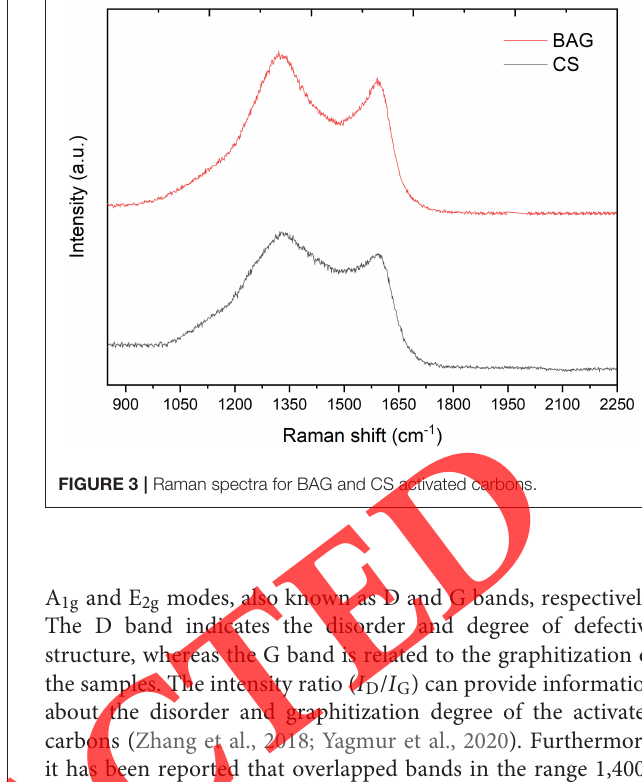
FIGURE 3 | Raman spectra for BAG and CS activated